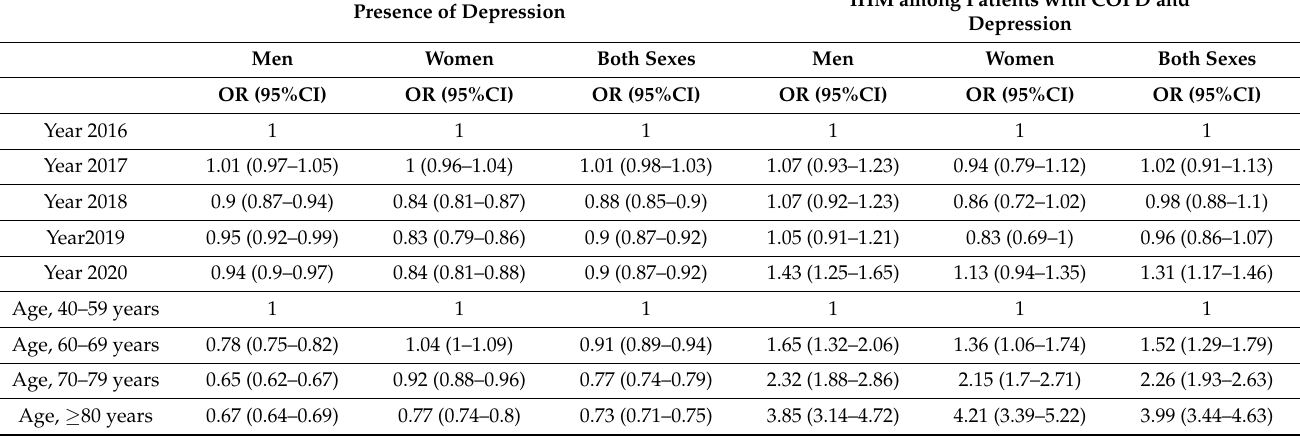
Table 5. Multivariate analysis of the factors associated with the presence of depression among men and women hospitalized with COPD and in-hospital mortality among patients with COPD and concomitant depression, Spain